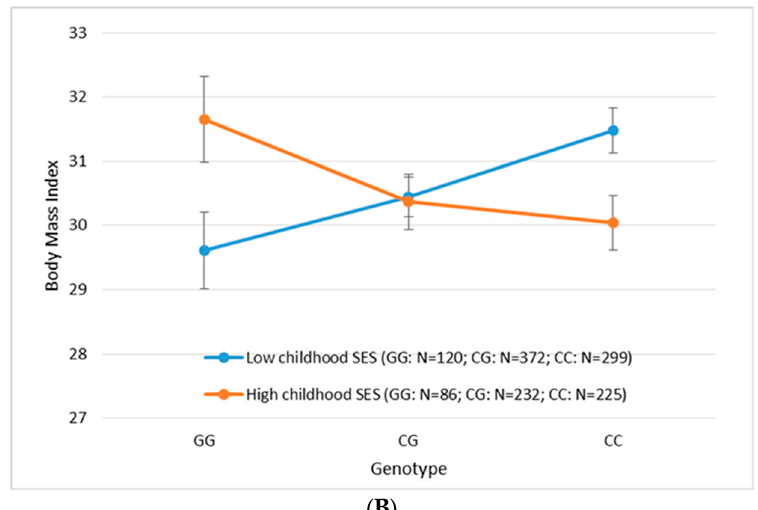
Figure 2 . Interaction between the most significant SNPs and childhood socioeconomic status (SES measured by parental education) on BMI in the Health and Retirement Study (HRS). Average covariate- adjusted BMI value across multiple exams was calculated for each participant. Mean BMI was plotted for participants in high and low childhood SES groups against different genotypes of the SNP rs9540488 ( beta snp = − 0.38, p snp = 0.0013, beta parental education = − 0.44, p parental education = 0.066, beta int = 0.85, p int = 6.91 × 10 − 6 ) in European Americans ( A ) and the SNP rs7997837 ( beta snp = − 0.67, p snp = 0.077, beta parental education = − 1.70, p parental education = 0.019, beta int = 1.65, p int = 0.00095) in African Americans ( B ). Parameters were estimated from longitudinal analysis via GEE models separately for European American participants ( N = 7838, M = 12,409) and African American participants ( N = 1338, M = 1861). N: number of participants; M; number of